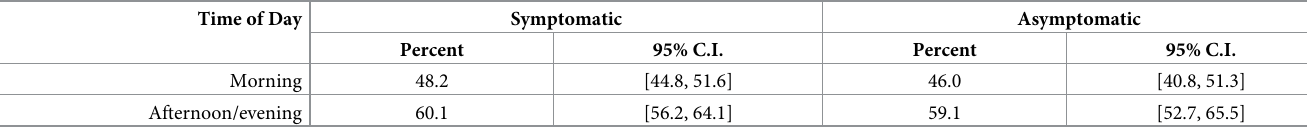
Table 5. Compound homophily estimates : Estimated proportion of contacts to own compound members by symptom status and time of day, two days before survey. Time of